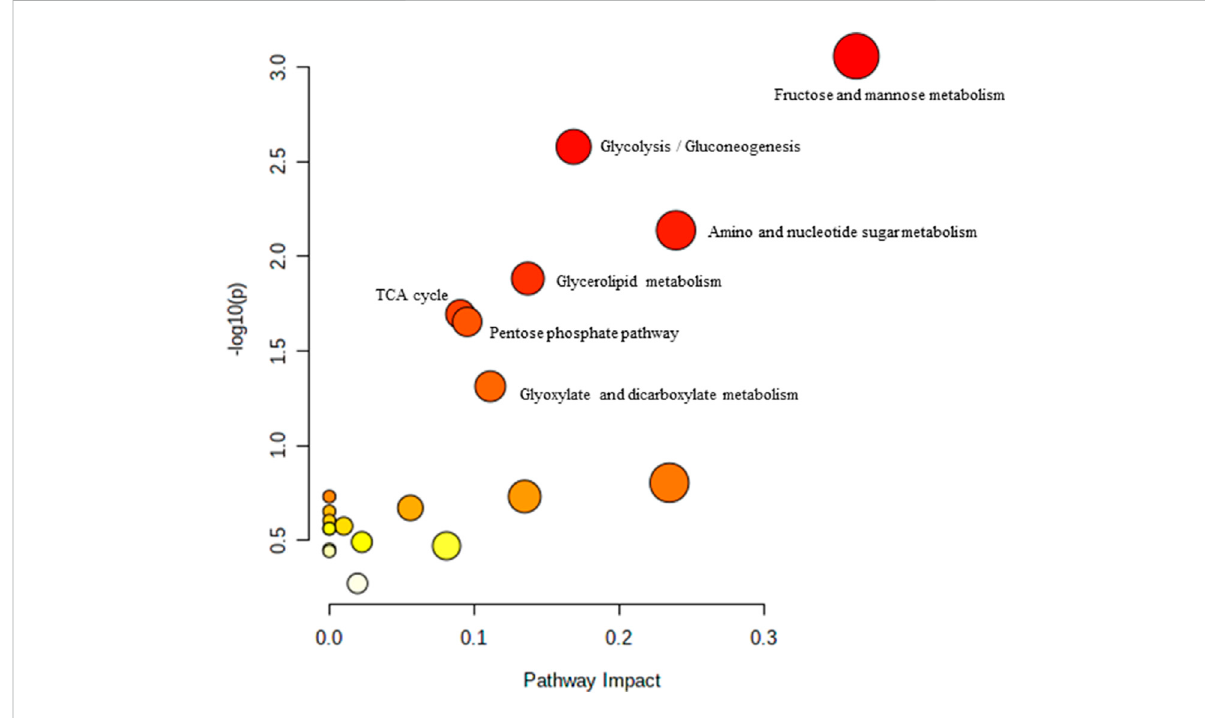
FIGURE 2 Biochemical pathway analysis of metabolites pro fi led for YC vs. AC.